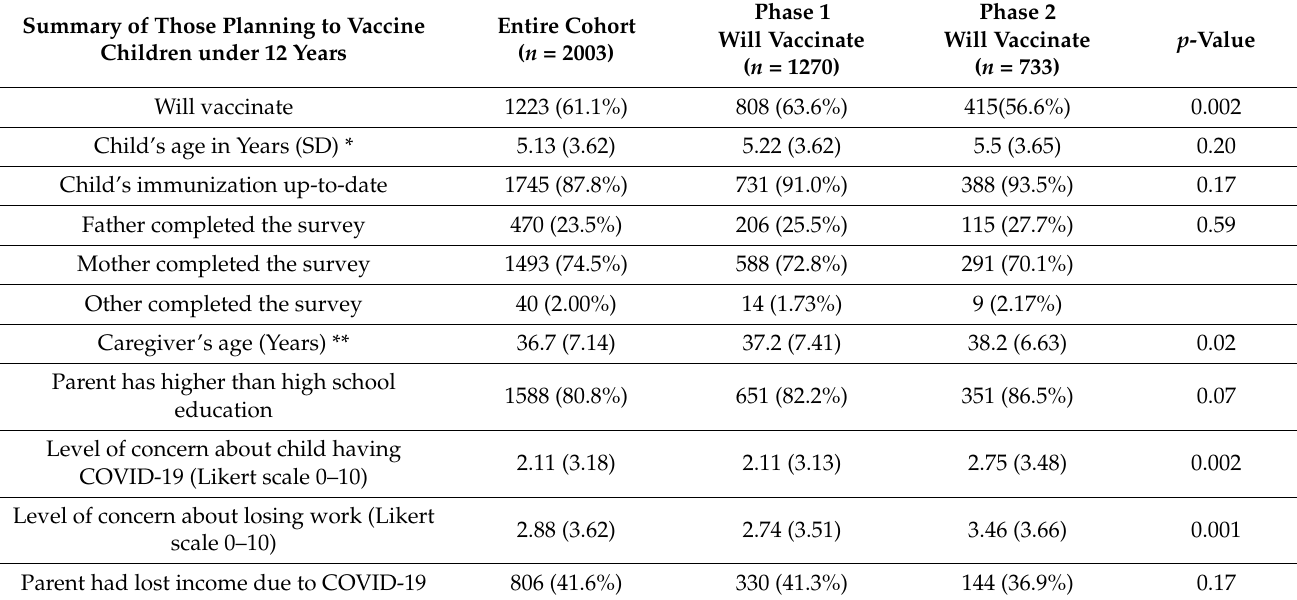
Table 2. Parents of children 12 years and younger who will vaccinate their children by phase of study.